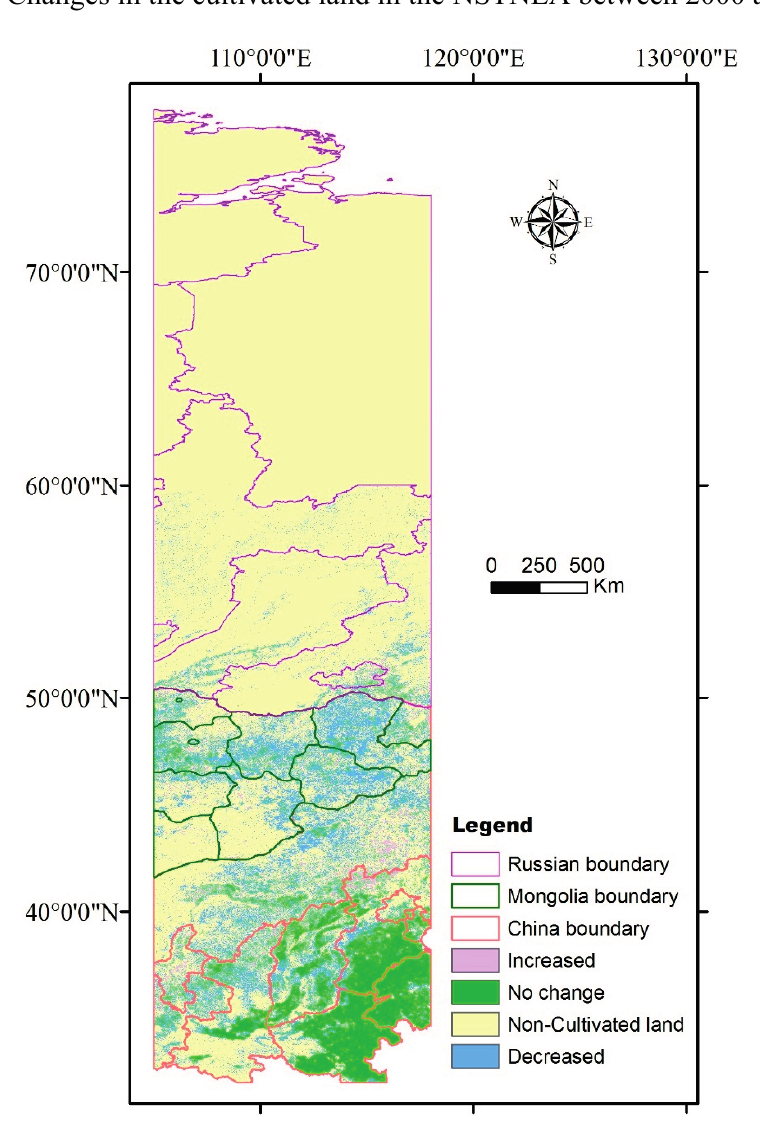
Figure 7. Changes in the cultivated land in the NSTNEA between 2000 and